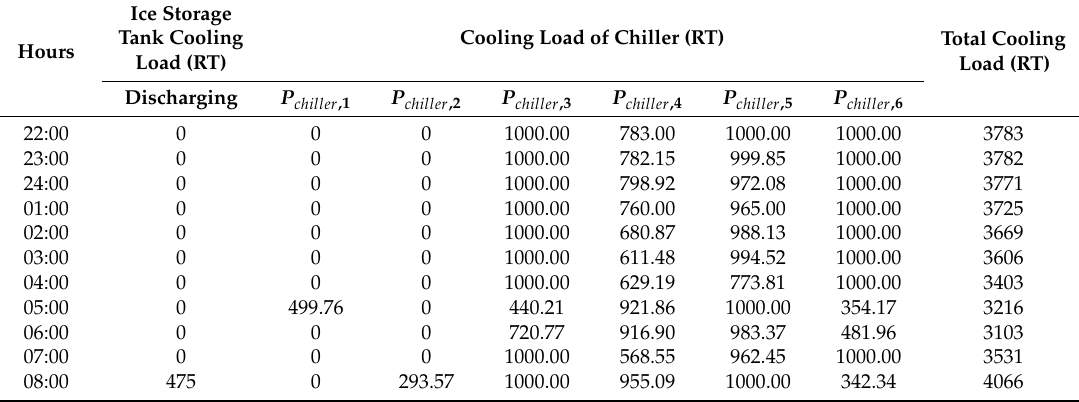
Figure 6. Convergence characteristics of PSO, TVAC-PSO, BSO and IRBSO for demand response scenario. Table 5 shows the ice storage air conditioning of average discharge and Tables 6 and 7 show the IRBSO at the dynamic electricity price intervals for demand response. Table 5. The IRBSO for ice storage air conditioning of average discharge.